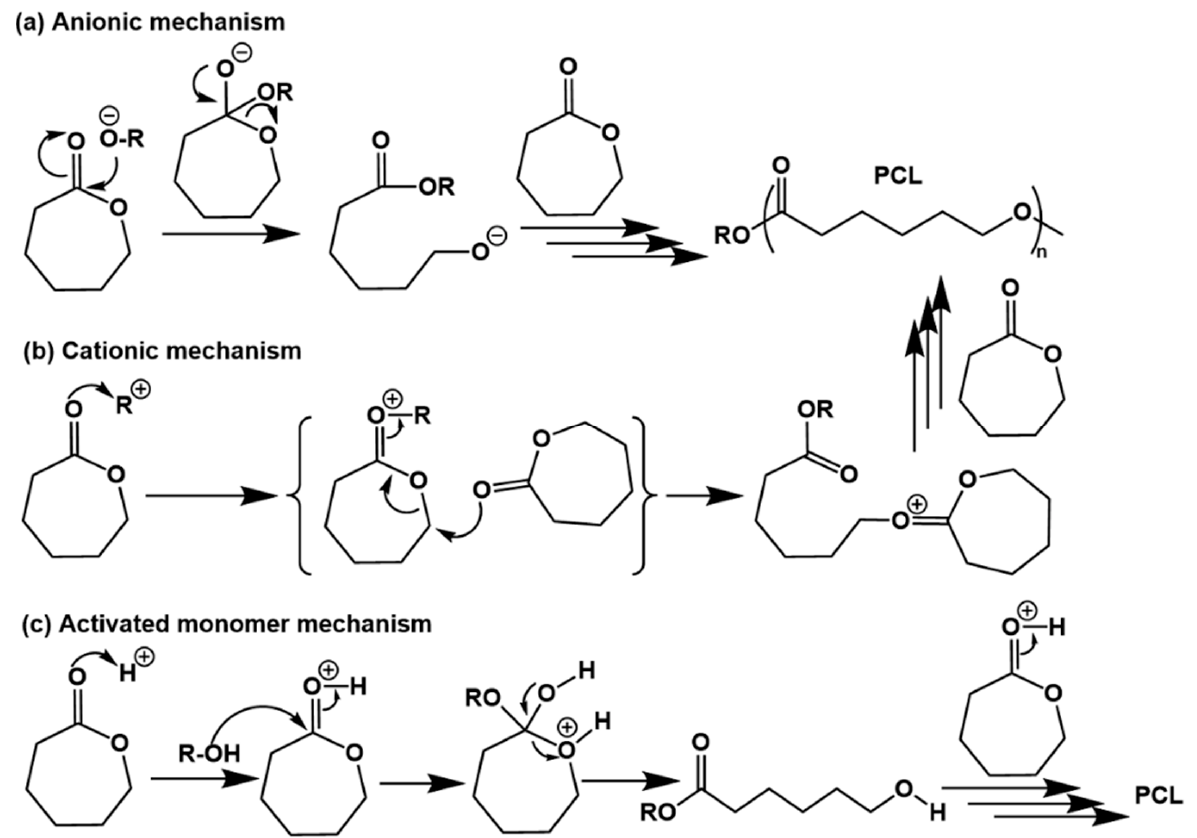
Figure 8. Reaction mechanism for ring-opening polymerization of caprolactones: ( a ) anionic polymerization mechanism, ( b ) cationic polymerization mechanism, ( c ) acid-activated monomer mechanism.